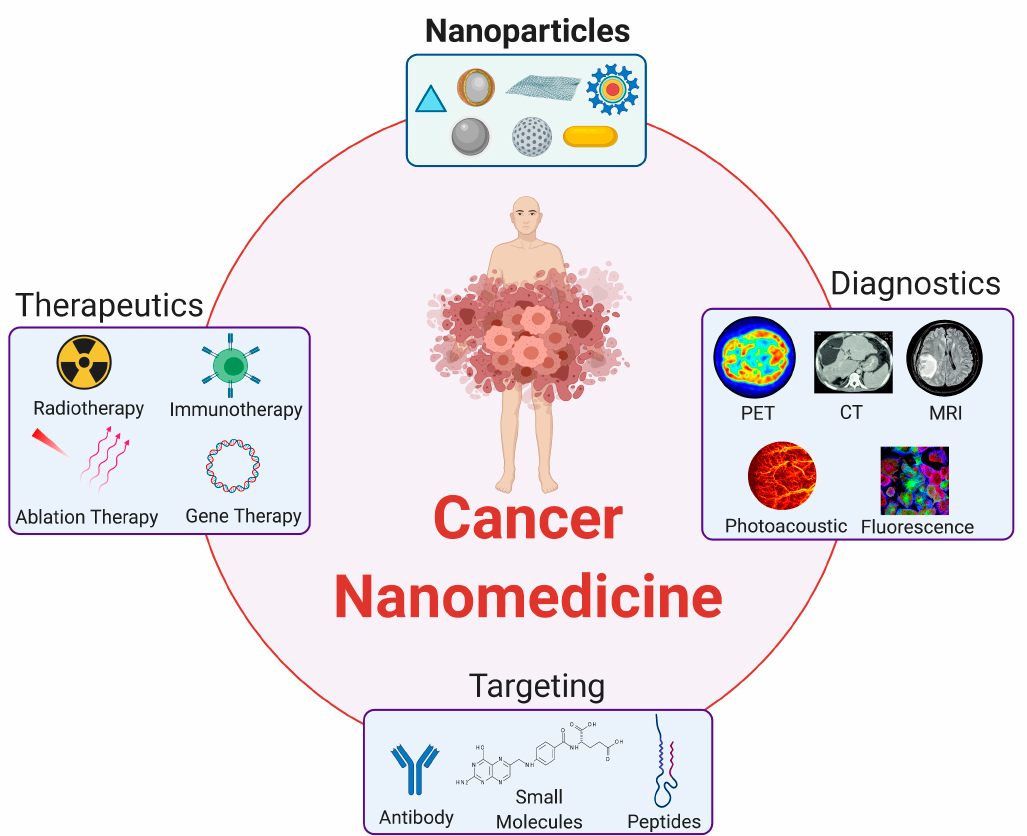
Figure 1. Nanoparticles in imaging and therapies. Created using BioRender.com.